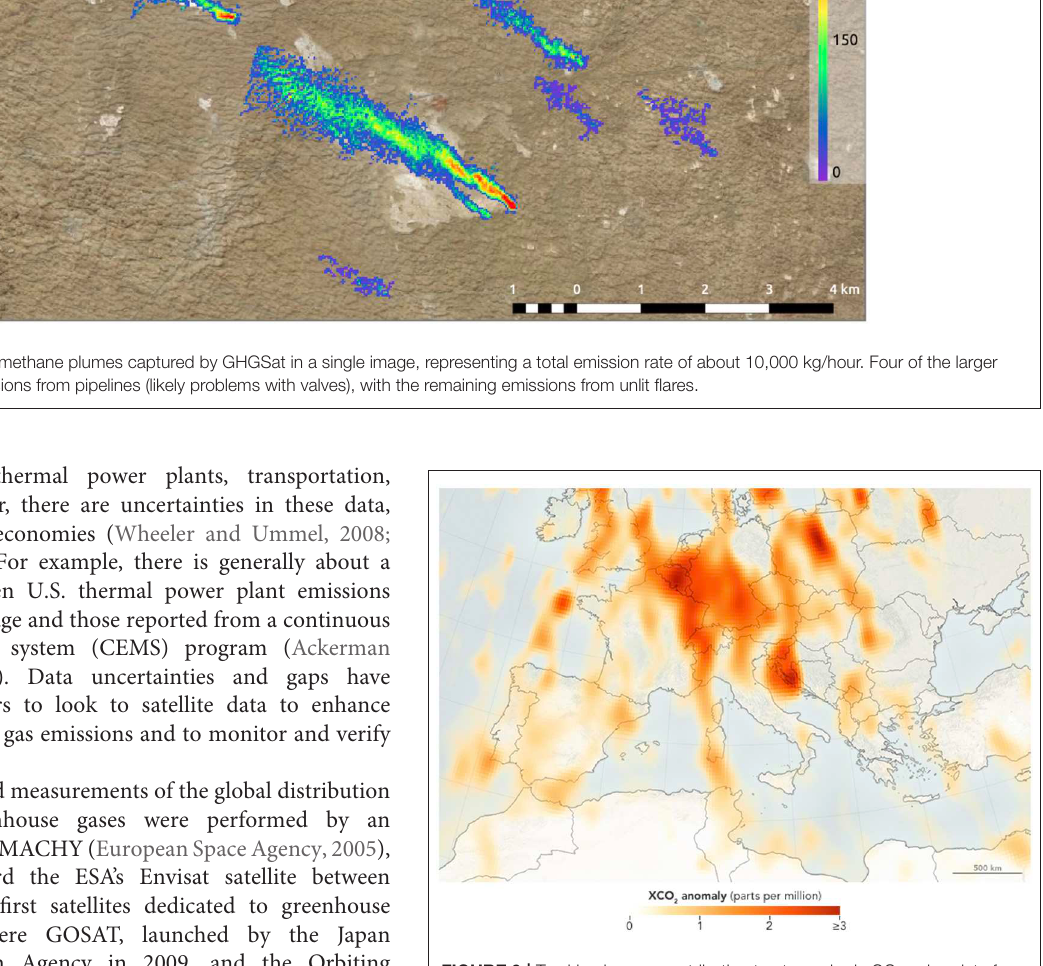
FIGURE 9 | Tracking human contribution to atmospheric CO 2 using data from NASA’s OCO-2 satellite. Here, anomalies are shown from between 2014-2016. [NASA Earth Observatory maps by Joshua Stevens, using OCO-2 anomaly data courtesy of Hakkarainen et al. (2016) (NASA, 2016)].